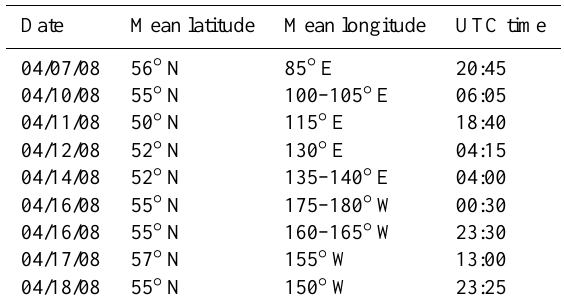
Figure 8c: Same as 8a and 8b but near the DC9 measurements